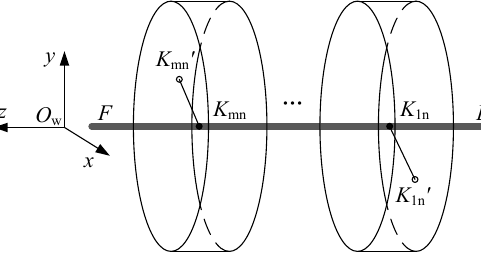
Figure 2. The ideal measurement model.